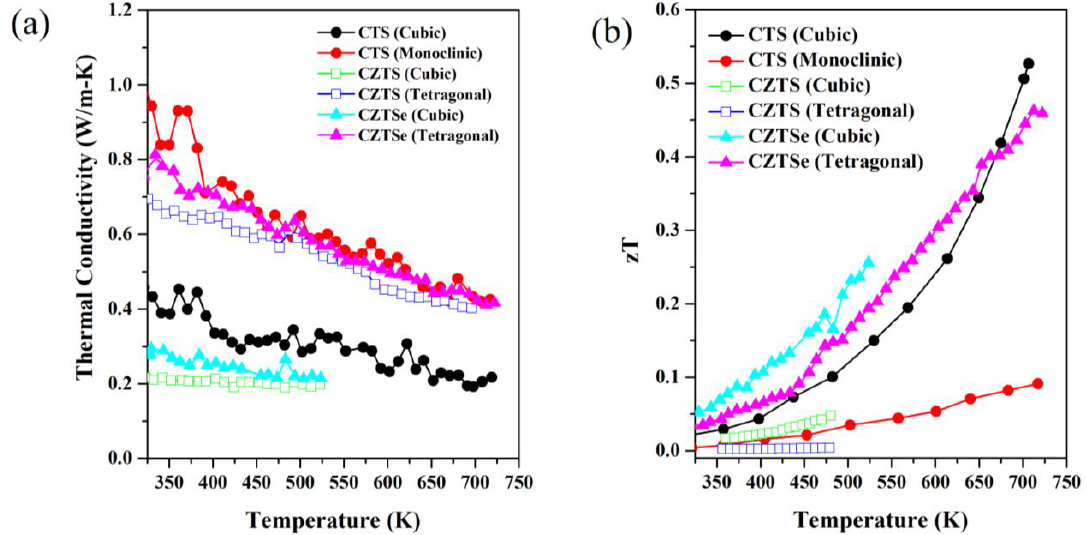
Figure 7. Temperature-dependent thermal conductivity ( a ) and zT ( b ) for CTS, CZTS, and CZTSe Figure 7 . Temperature-dependent thermal conductivity (a) and zT ( b ) for CTS, CZTS, and CZTSe polymorphs data retrieved from [20,34,51,52]. polymorphs data retrieved from